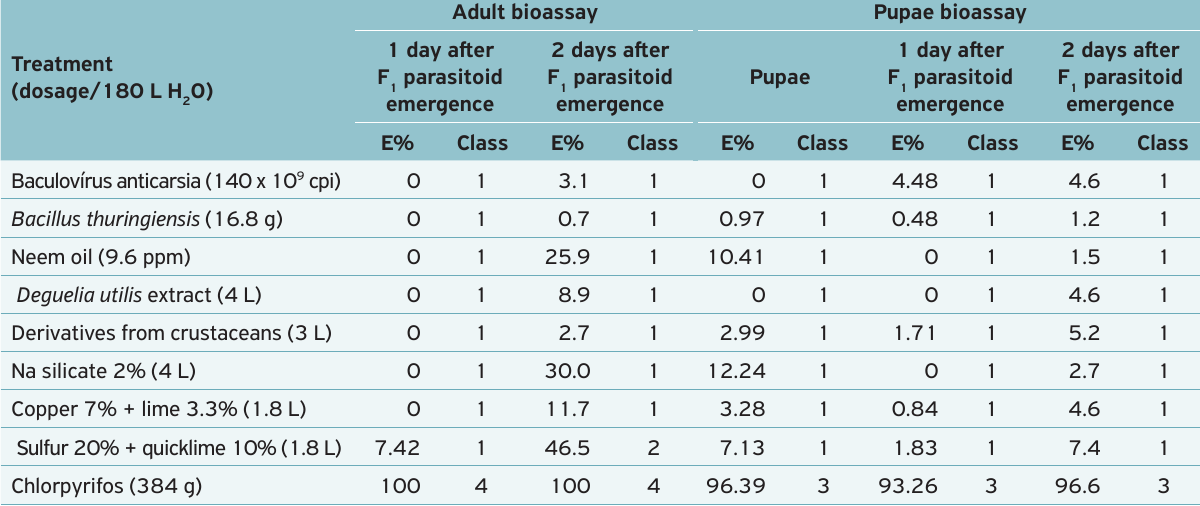
Table 3. Placement of organic agricultural supplies sprayed on the egg parasitoid Trichogramma pretiosum into International Organization for Biological Control survival side effect